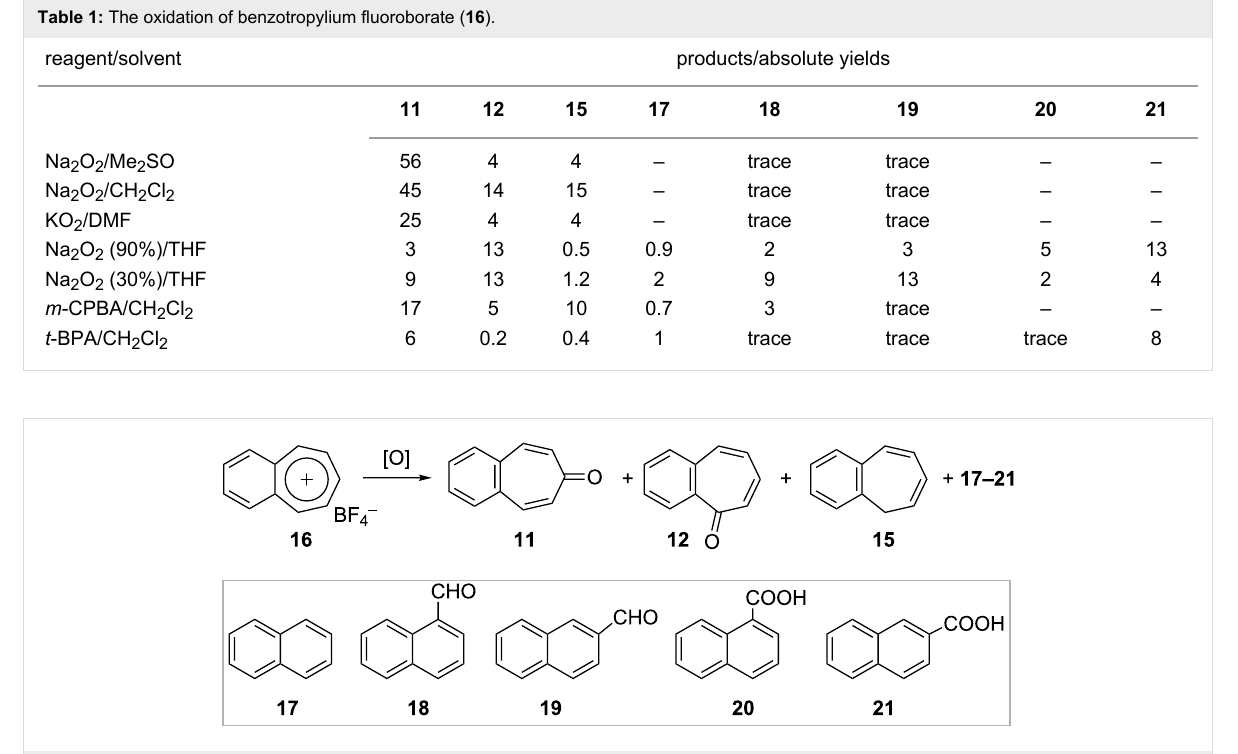
Scheme 3: Oxidation products of benzotropylium fluoroborate ( 16